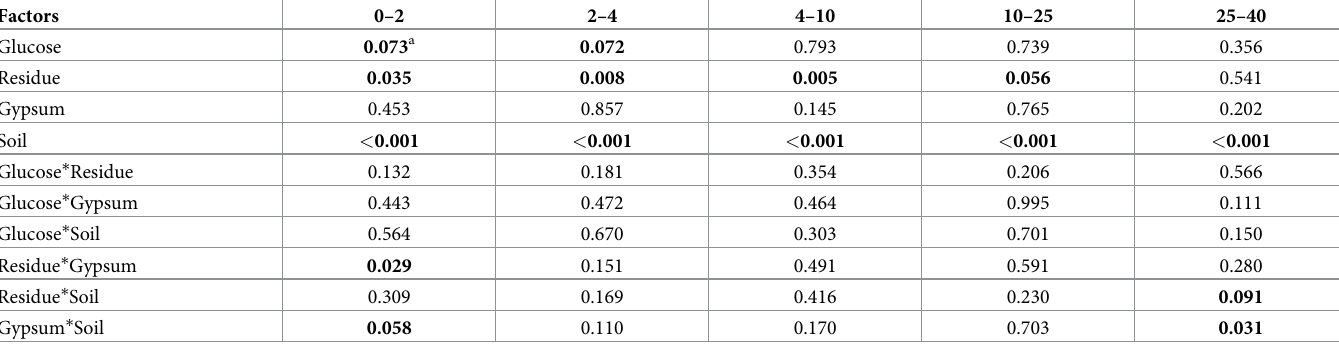
Table 3. Probability values of significant factors of direct effects and interaction effects on total soil C concentrations in different soil layers averaged across the two